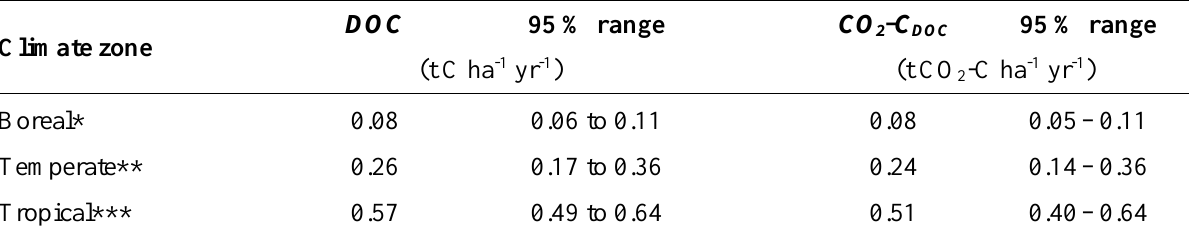
Table 3. Emission factors for dissolved organic carbon ( DOC : t C ha -1 yr -1 ) and CO 2 -C DOC (t CO 2 -C ha -1 yr -1 ) and associated uncertainty ranges (95 % confidence intervals). Note rounding artefact on DOC values for boreal climate